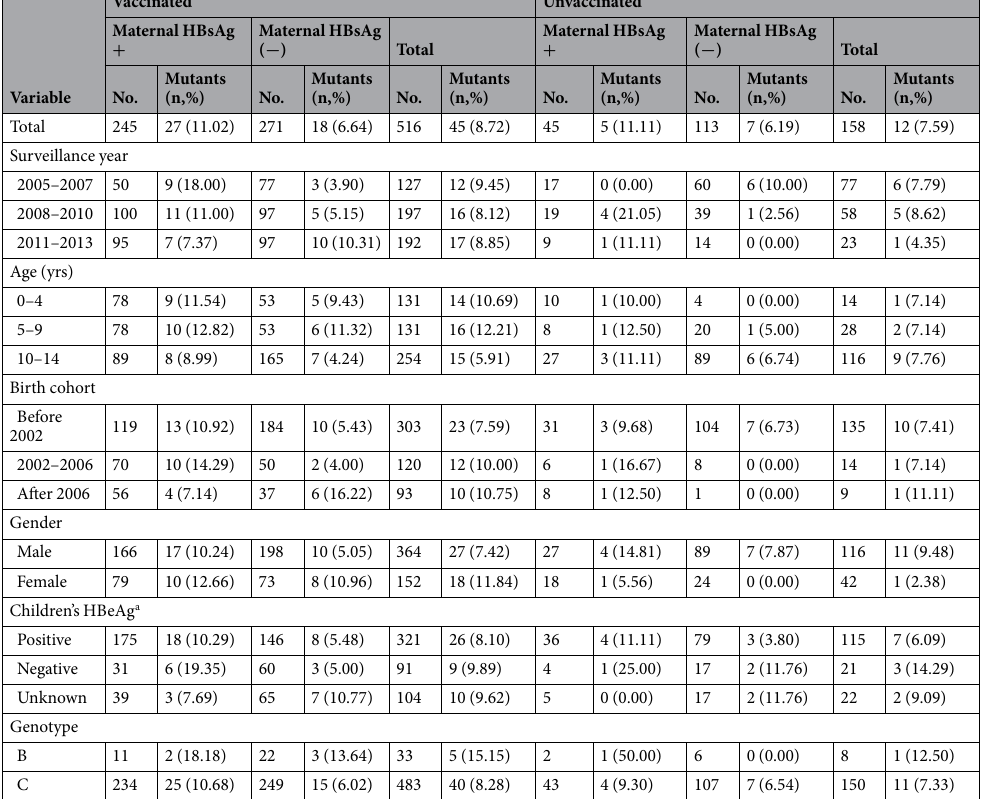
Table 1. Prevalence of “ α ” determinant mutations among hepatitis B cases according to selected characteristics. a Children’s HBeAg was obtained from the medical records in hospital.